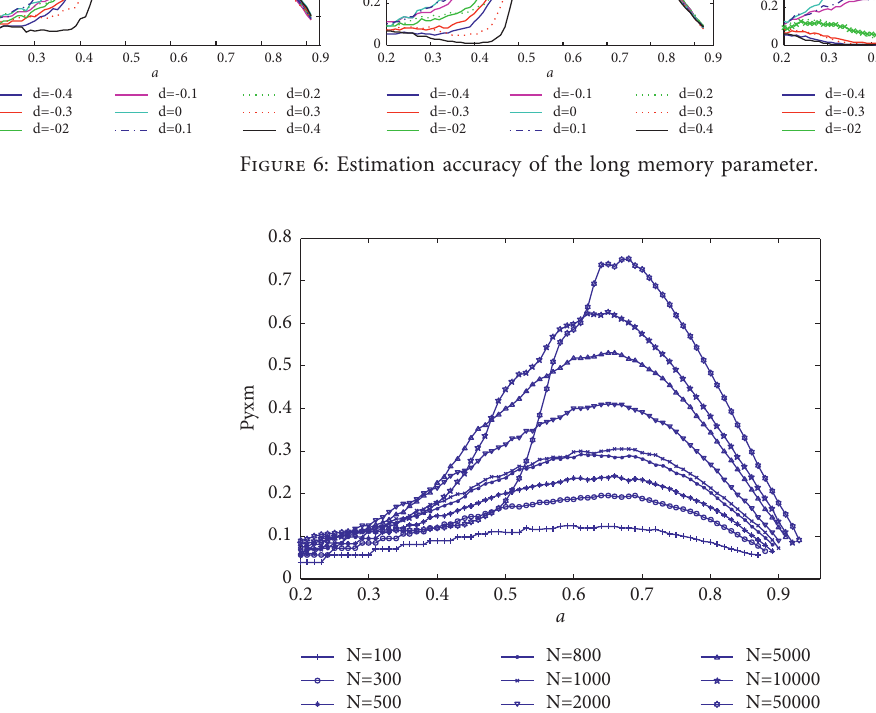
Figure 7: Average estimation accuracy of long memory parameter d